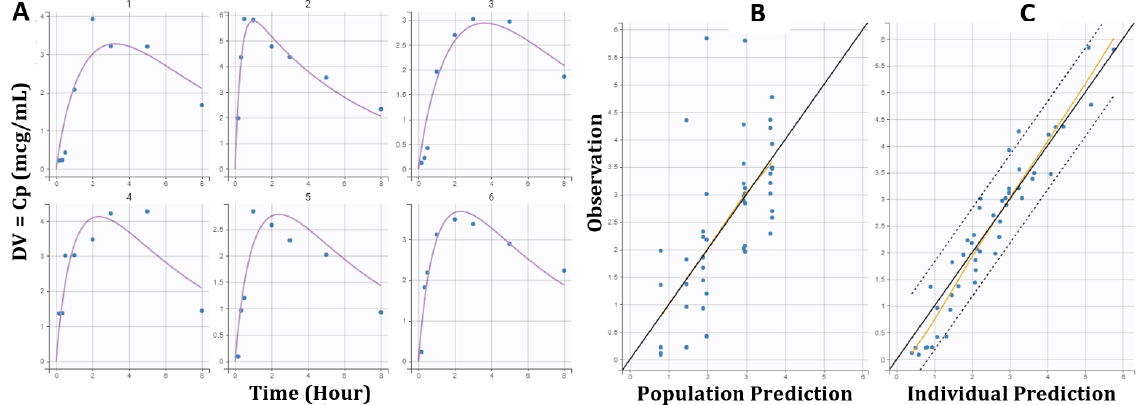
Figure 4. The goodness of fit of the two-compartment open model of levofloxacin after peroral administration, i.e., individual data fitting analyses (panel A); observation versus population prediction analysis (panel B) and observation versus individual prediction analysis (panel C), with a combination error model